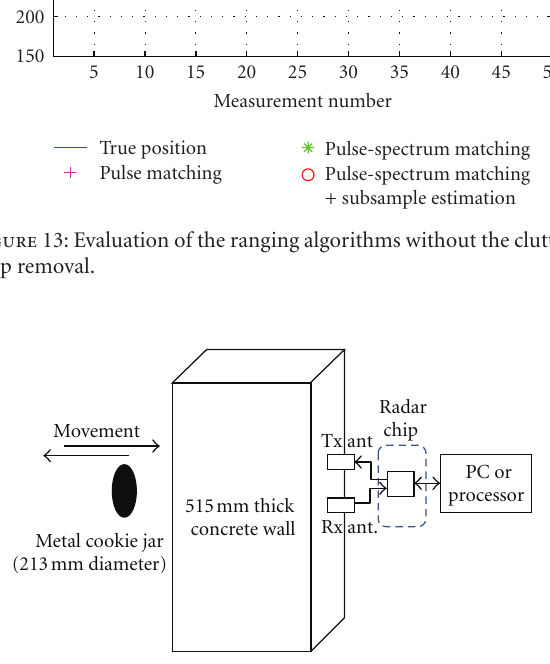
Figure 14: The setup for the evaluation of the one-dimensional tracking algorithm through a concrete corridor wall.